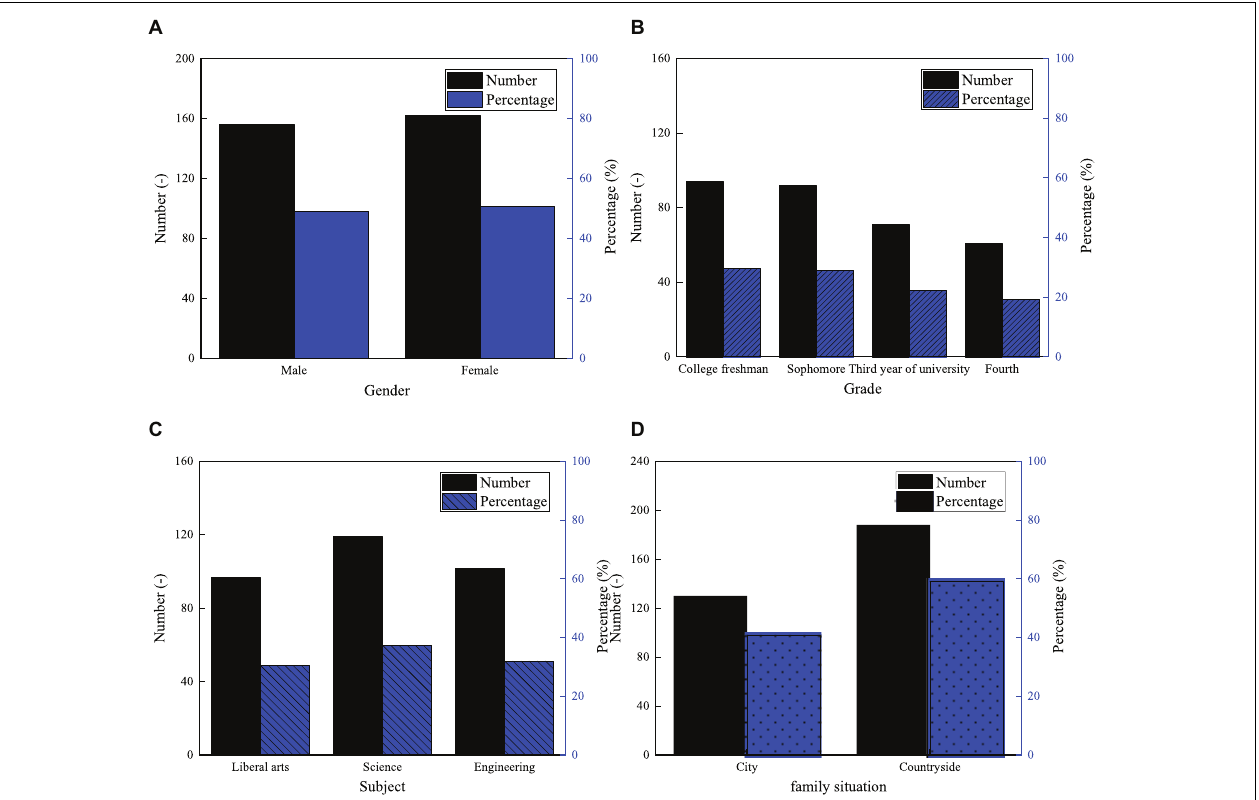
FIGURE 1 | Basic information of the respondents. Statistical results of the respondents according to (A) gender, (B) grade, (C) subject, and (D) family situation are shown.